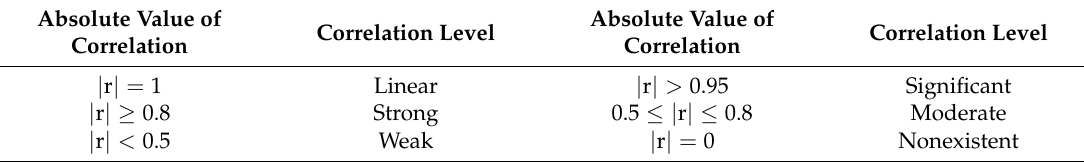
Table 1. The general decision range of two variables’